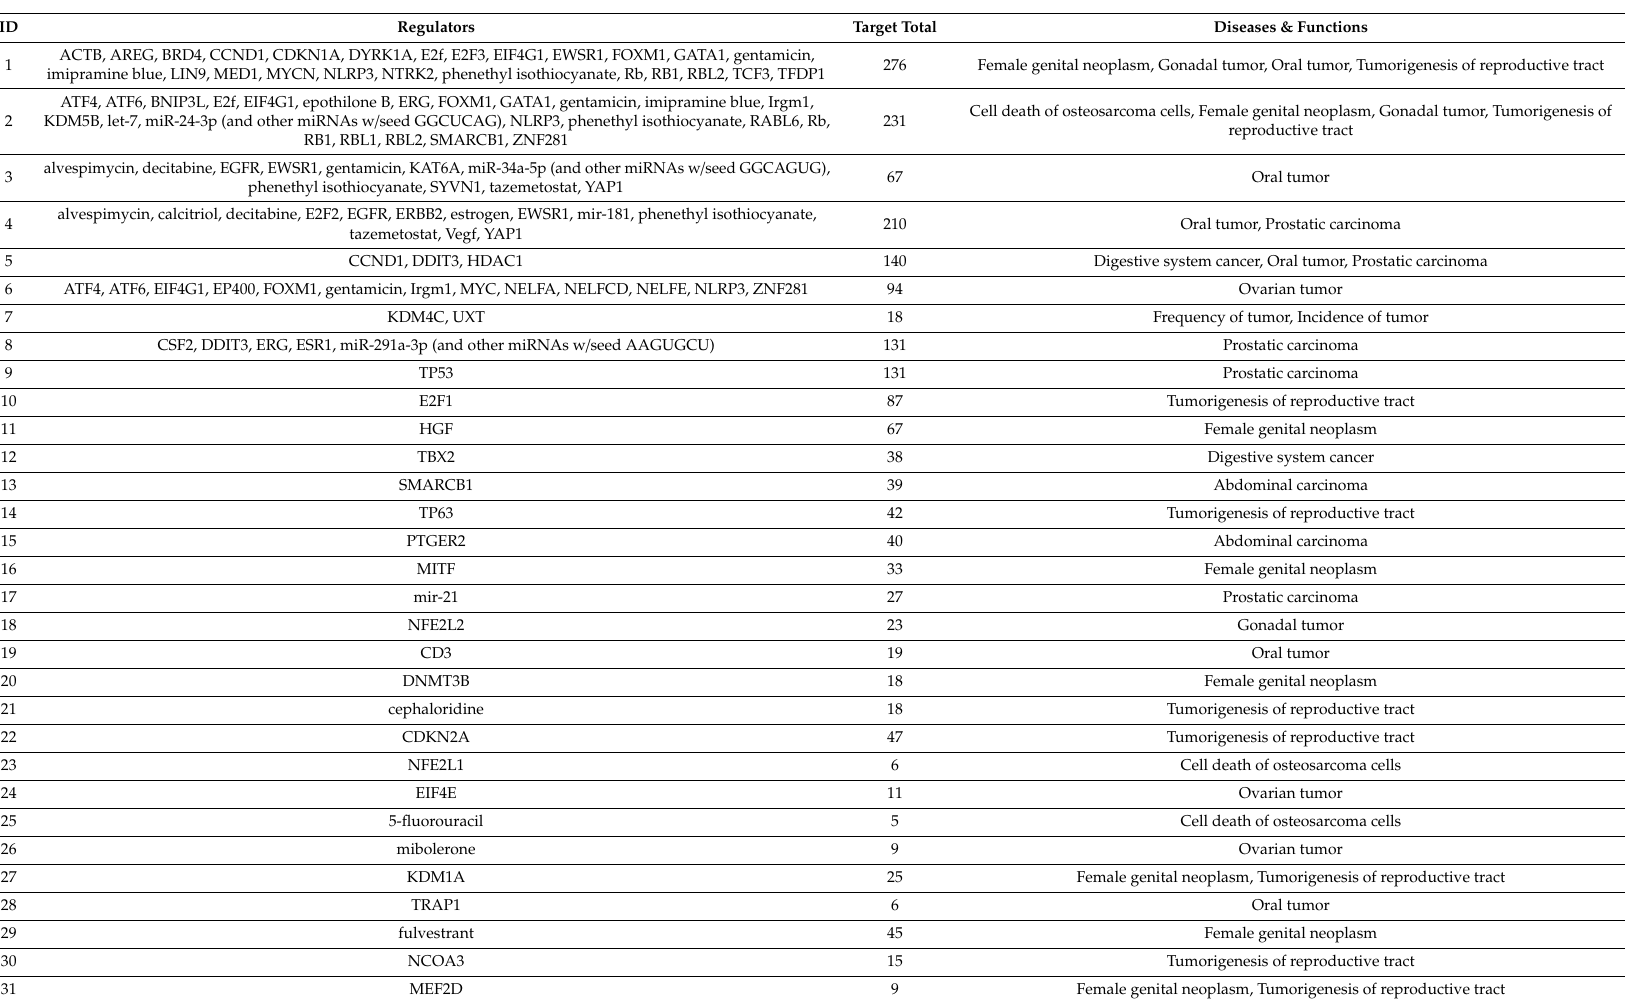
Table 4. Regulator e ff ect networks related to cancer in di ff use-type gastric cancer (GC). Regulator e ff ect networks related to cancer have been generated. Type of regulators include biological drug, canonical pathway, and chemical